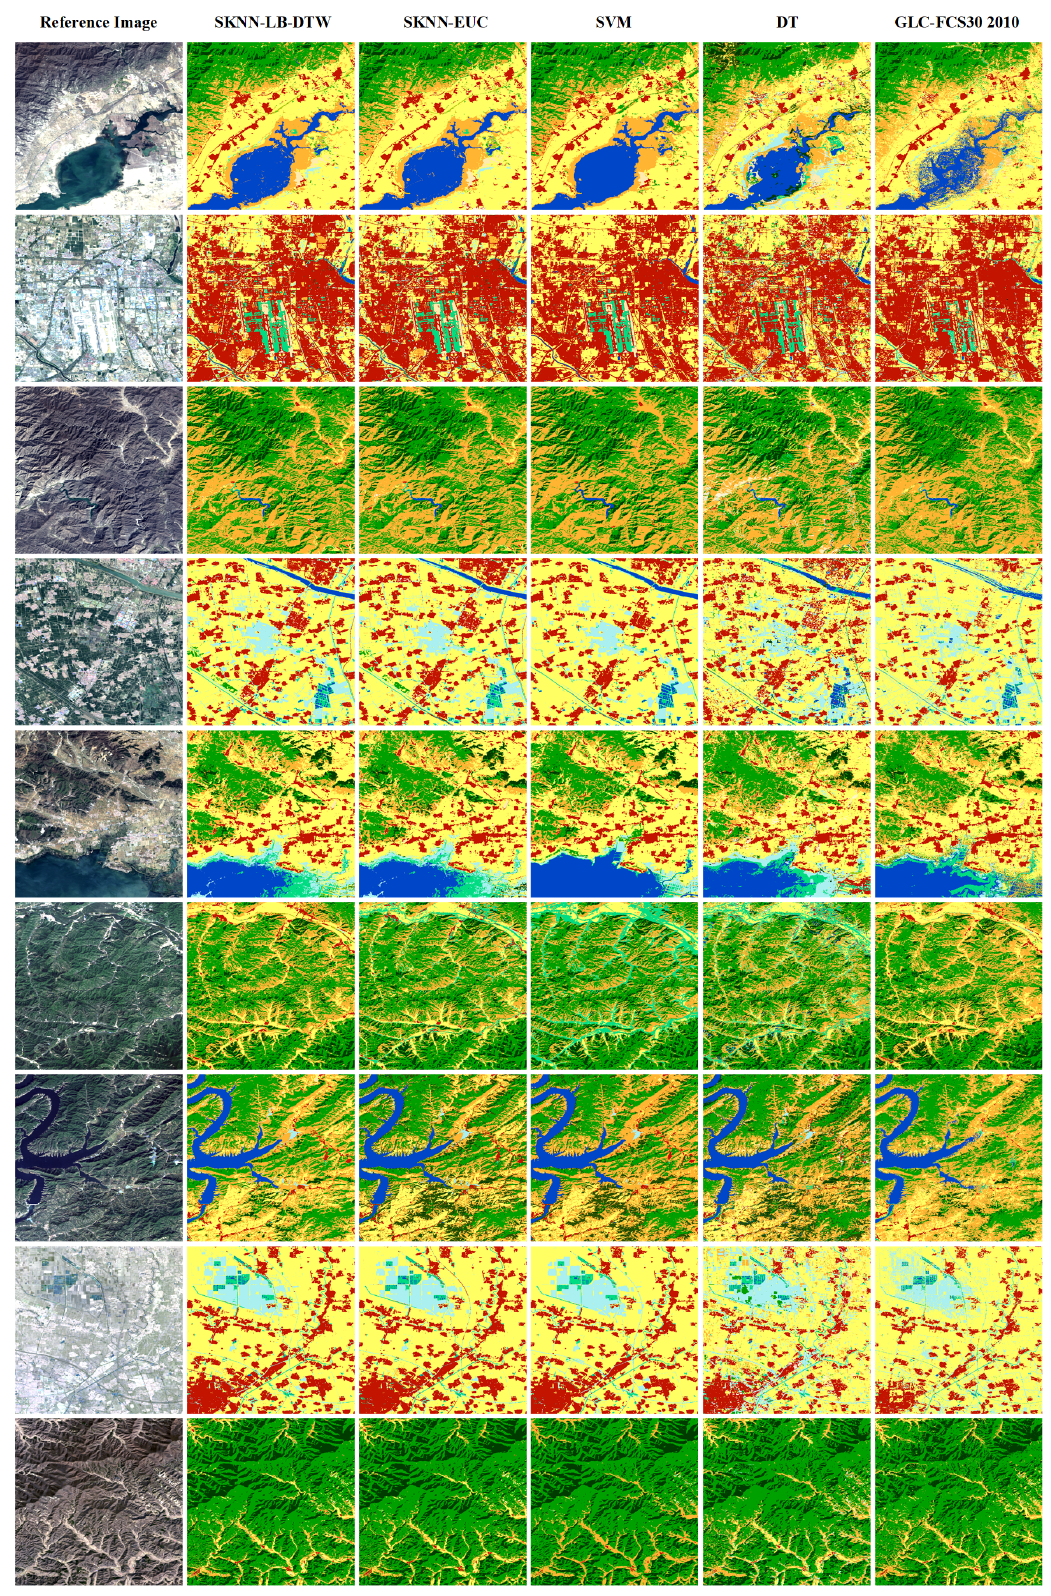
Figure 8. Comparison between the proposed SKNN-LB-DTW method and the competing methods with multiple cases. We still observe the terrain and texture of land cover in the classification maps due to the fine-grained classification system enabled by the rich information contained in SITS